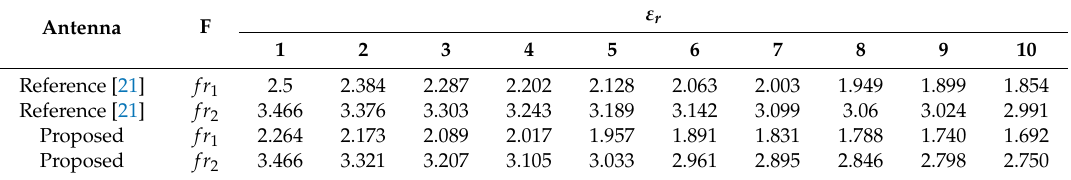
Table 2. Simulated f r (GHz) range values for changes in relative MUT